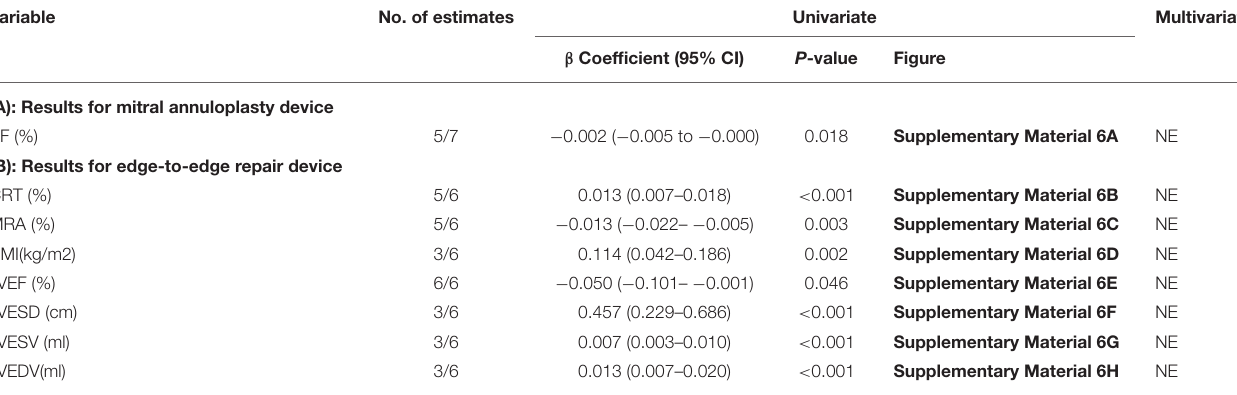
TABLE 3 | Subgroup meta-regression analysis for all-cause mortality in mitral annuloplasty device (A) and edge-to-edge repair device (B) .